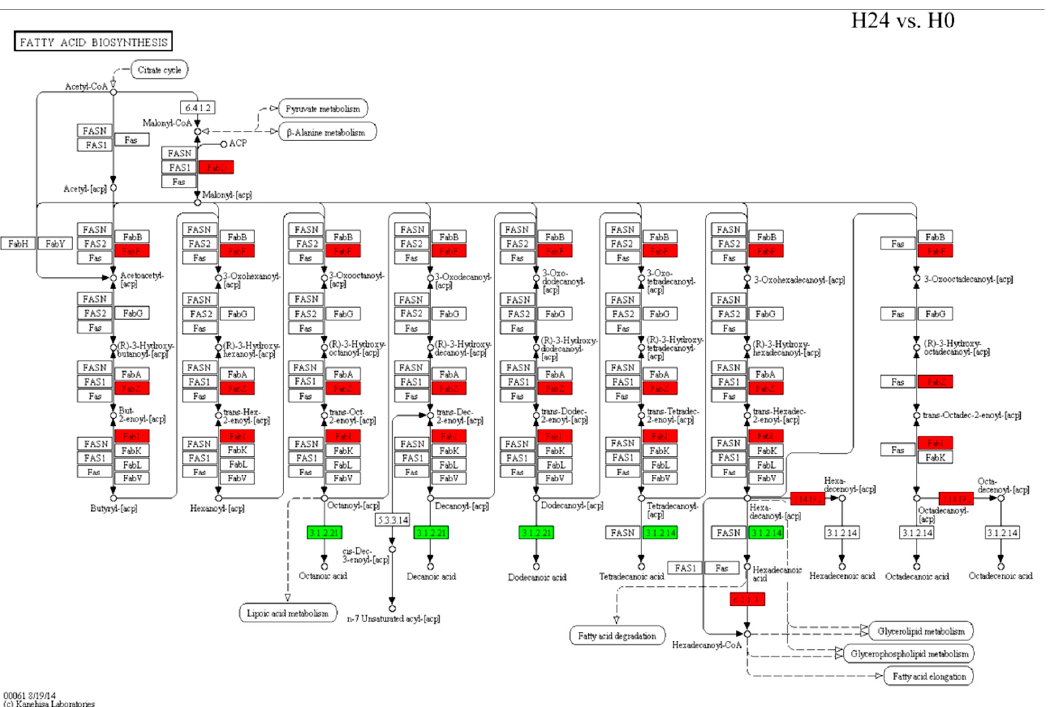
Figure 4. Gene expressions in the fatty acid biosynthesis pathway (Ko00061) in response to Bgt infection. The red color indicates gene expression induction by Bgt ; the green color indicates gene expression reduction by Bgt .